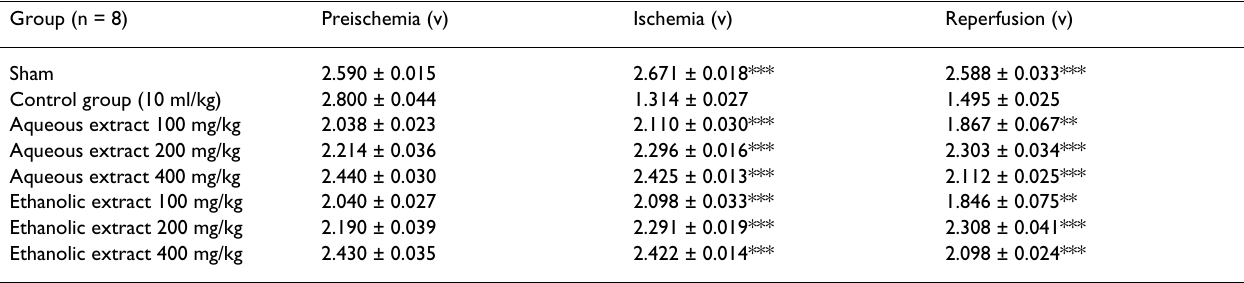
Table 1: Effects of Salvia leriifolia root aqueous and ethanolic extracts on average peak-to-peak amplitudes of EMG signals, prior, during and after ischemia-reperfusion in rat skeletal muscle. Group (n =